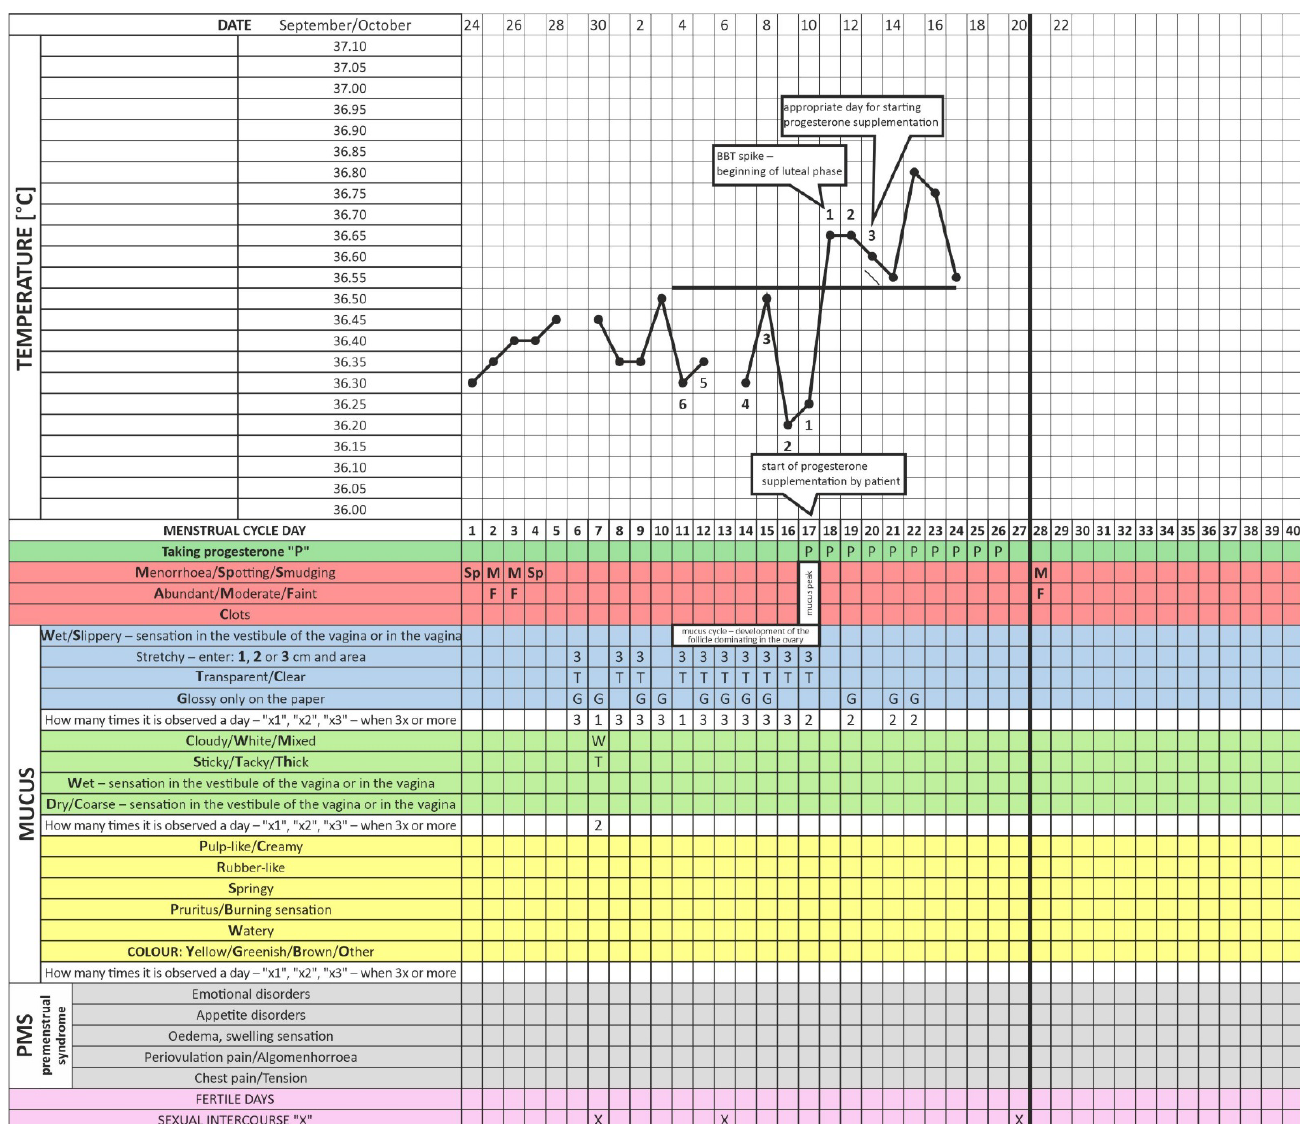
Figure 1. Menstrual cycle observation chart at the time when the patient started taking progesterone incorrectly—too early— (i.e., on Day 22 of the menstrual cycle).